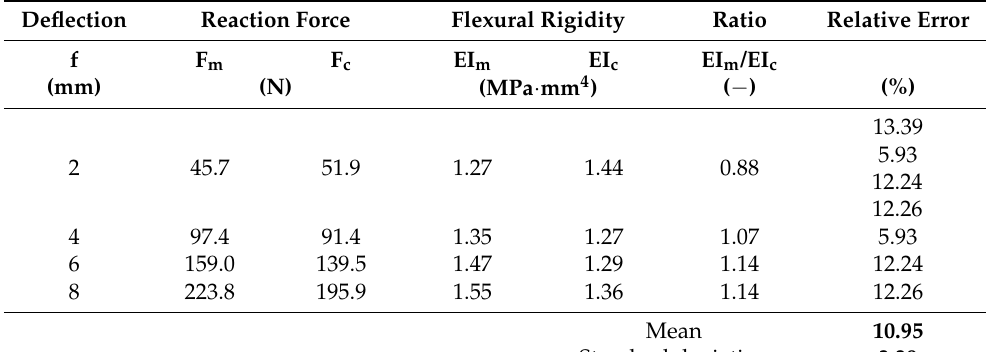
Table 1. The ratio of measured (subscript “m”) and calculated (subscript “c”) flexural rigidity. Deflection Reaction Force